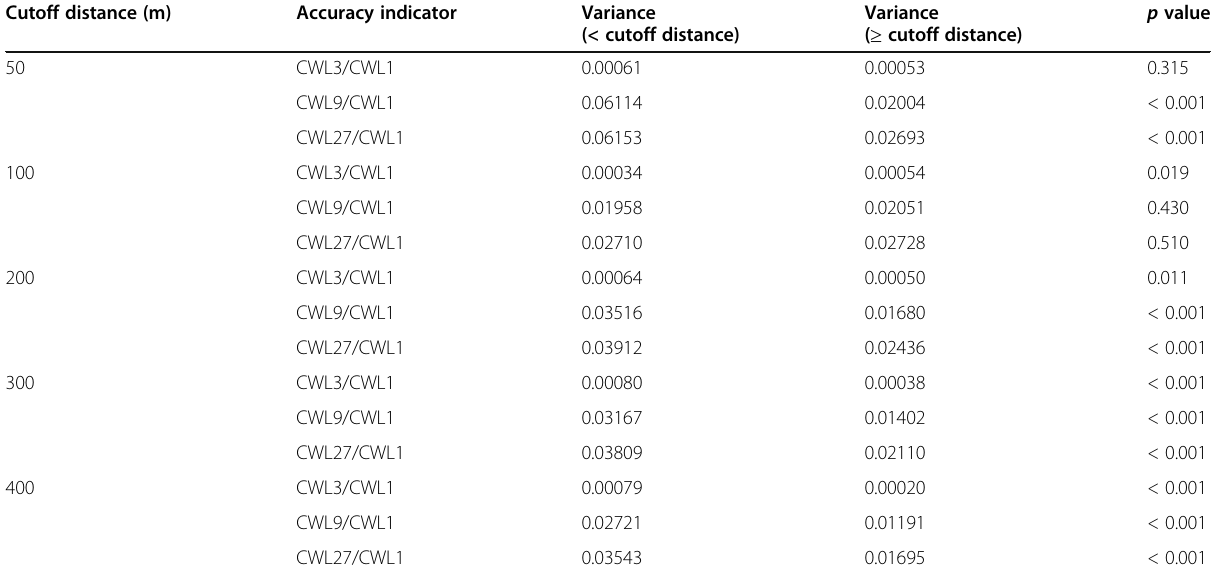
Table 4 Variances of each of CWL3/CWL1, CWL9/CWL1, and CWL27/CWL1 for closer source-sink pairs and the remaining source-sink pairs in the case of two barriers Cutoff distance